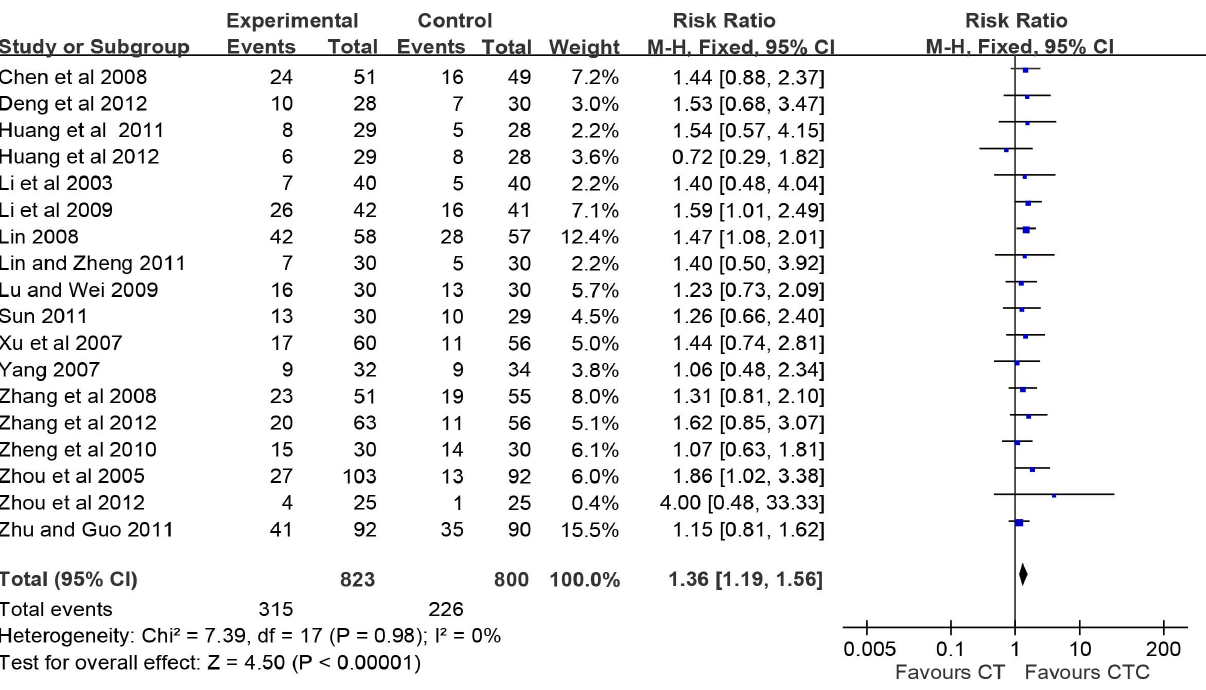
Figure 3. Immediate tumor responses. Immediate tumor responses estimated from meta-analysis of pairwise comparisons in patients with chemotherapy combined Chinese herbal medicine (CTC, treatment group) versus patients in chemotherapy (CT, control group).